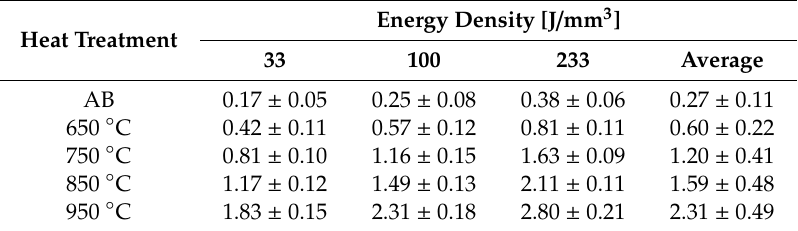
Figure 13. SEM images of microstructure of heat treated samples: ( a ) 650 ◦ C, ( b ) 750 ◦ C, ( c ) 850 ◦ C, and ( d ) 950 ◦ C. Table 5. Change the grain size in respect of energy density and